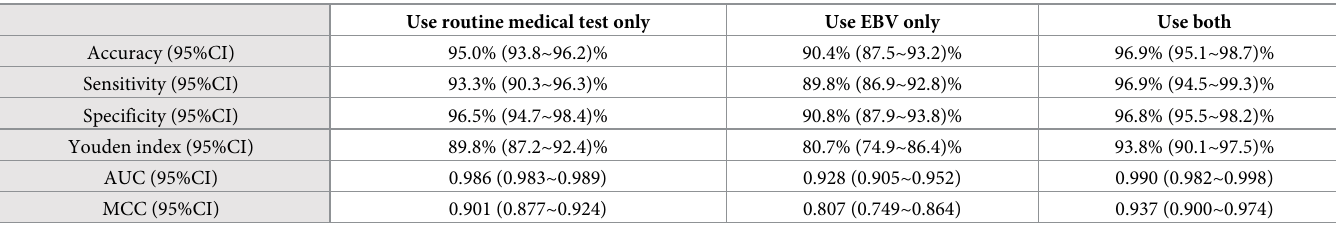
Table 7. The performance of RF in detecting NPC.